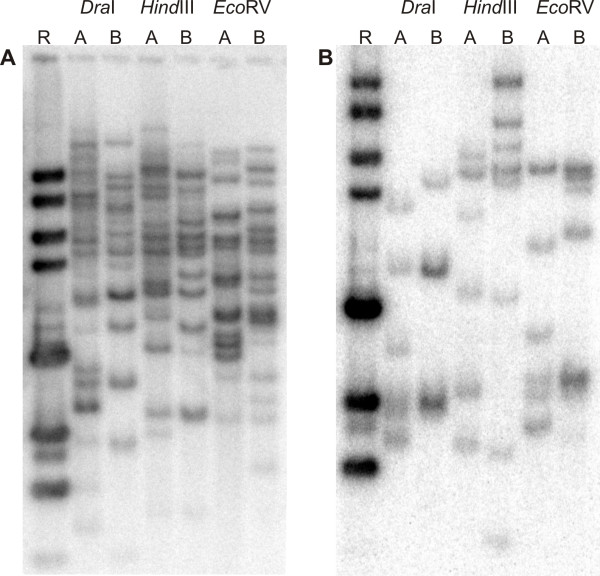
Multiple loci polymorphisms observed in M. acuminata parentals with RGA genetic markers. Polymorphisms were observed in DraI, HindIII, and EcoRV-digested genomic DNA from M. acuminata spp. microcarpa genetic map parentals Borneo and Pisang Lilin, following hybridization of Southern blots with RGA probes MaRGA08 (panel A) and MaRGA37 (panel B).